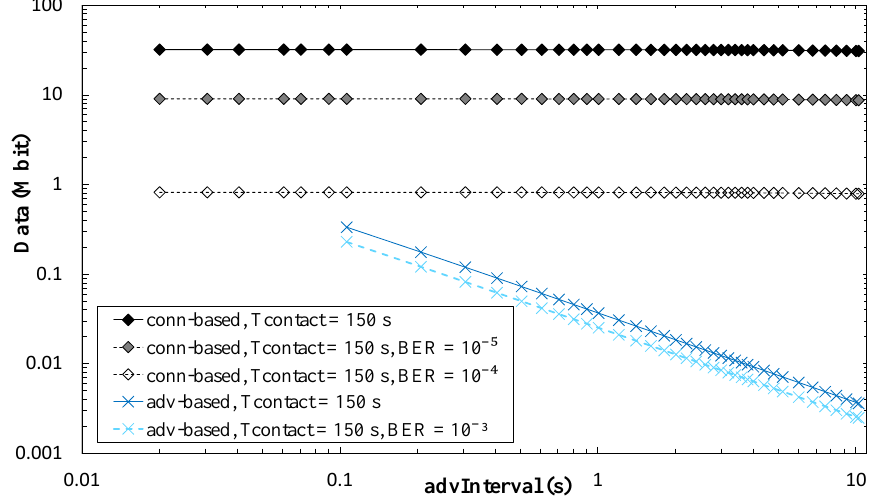
Figure 19. Maximum amount of collected data per contact interval, for the advertisement-based and connection-based approaches, as a function of advInterval , for different BER values, and for T contact = 150 s. connInterval = 4 s has been assumed.